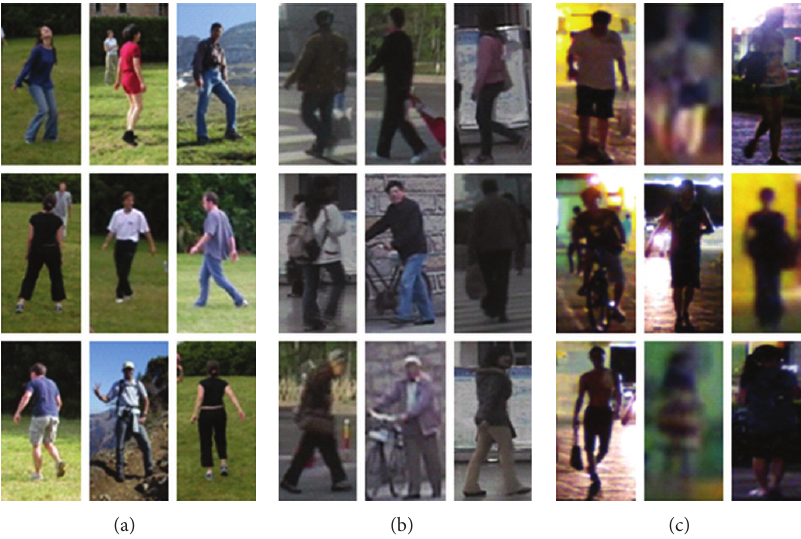
Figure 4: Examples of pedestrian images: (a) INRIA; (b) XMU-VIS; (c) XMU-NIR.